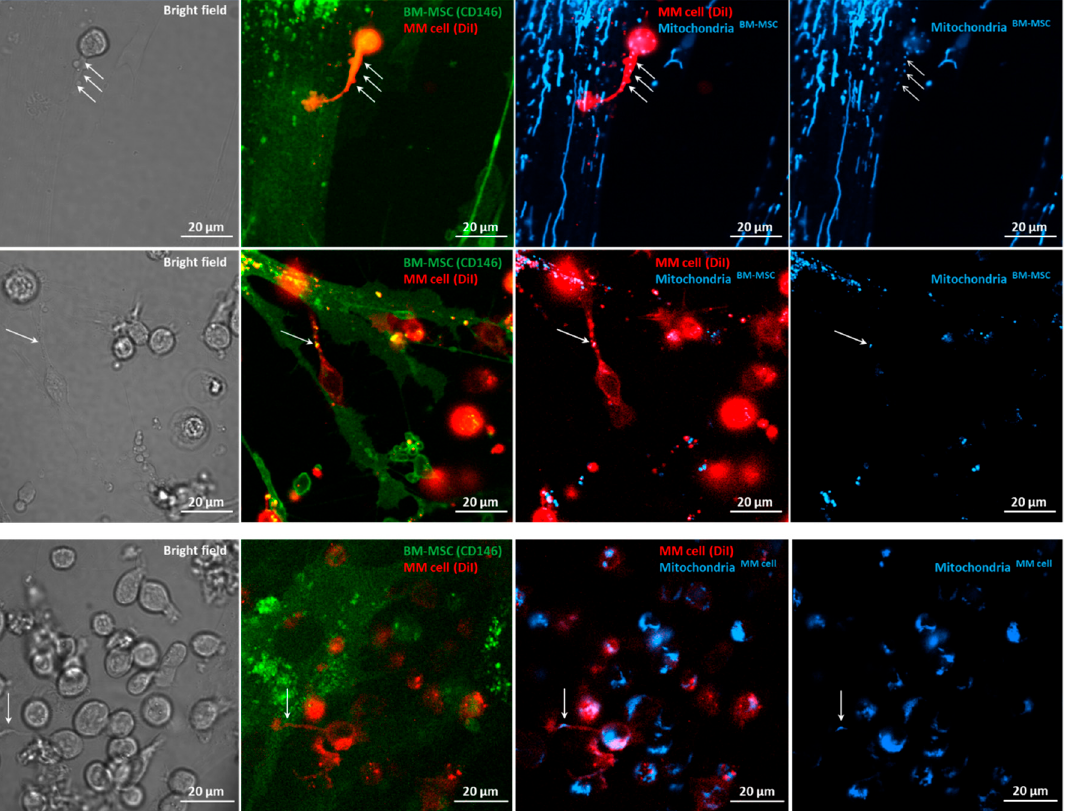
Figure 6. Visualization of tunneling nanotubes (TNTs) during mitochondrial transfer between BM-MSCs and MMs with confocal laser scanning microscopy. BM-MSCs and MMs were labeled with anti-CD146 conjugated with eFluor 450 (green) or with Vybrant DiI membrane-labeling dye (red), respectively ( A , B ). The mitochondria in BM-MSCs ( A ) or MMs ( B ) were stained with MitoTracker Red FM dye (blueish). MitoTracker Red FM-labeled BM-MSCs ( A ) or MMs ( B ) were co-cultured for 24 h with the recipient cells. A and B, left, show the bright field images of BM-MSC–MM co-cultures. The second column images show overlaps between BM-MSCs and MMs; the third column images show overlaps between BM-MSC-derived mitochondria in BM-MSCs and MMs ( A ) or MM cell-derived mitochondria in MMs and in BM-MSCs ( B ), and images on the right show BM-MSC-derived mitochondria ( A ) or MM cell-derived mitochondria ( B ). White arrows show the mitochondrial transfer from BM-MSCs to MMs ( A ) or from MMs to BM-MSCs ( B ) through MM cell-derived TNTs.